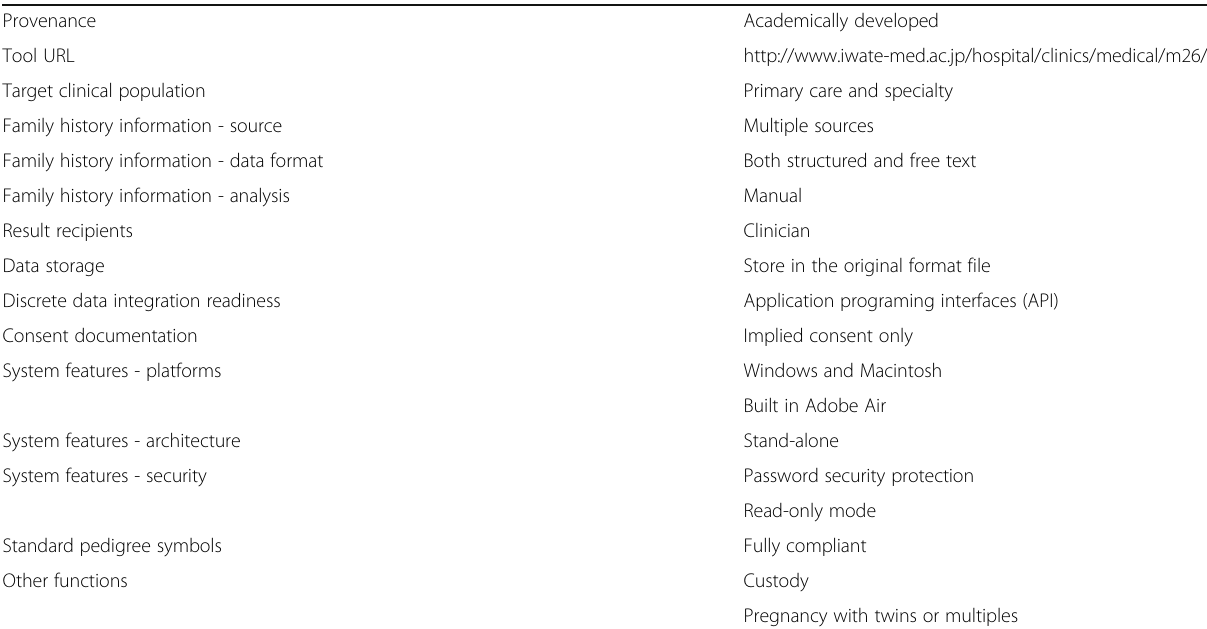
Table 3 f-treeGC